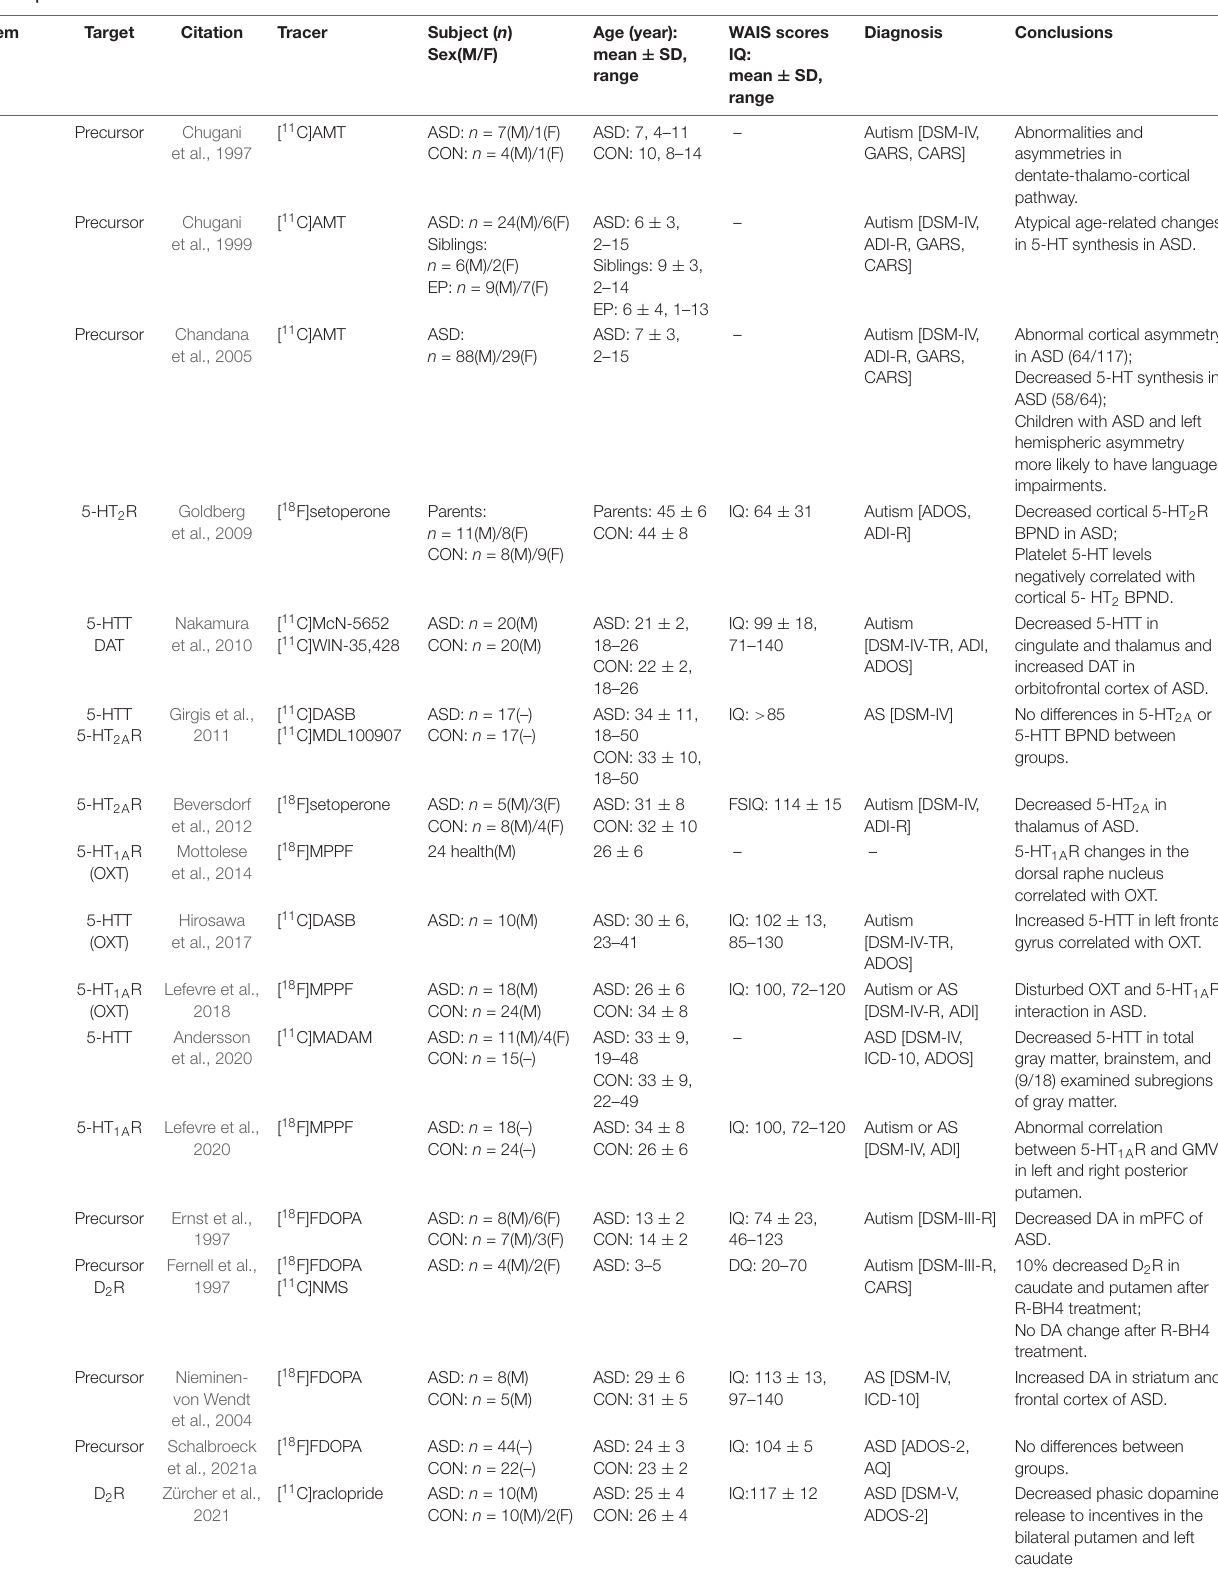
TABLE 4 | Neurotransmitter and neuroinflammation PET studies in ASD.